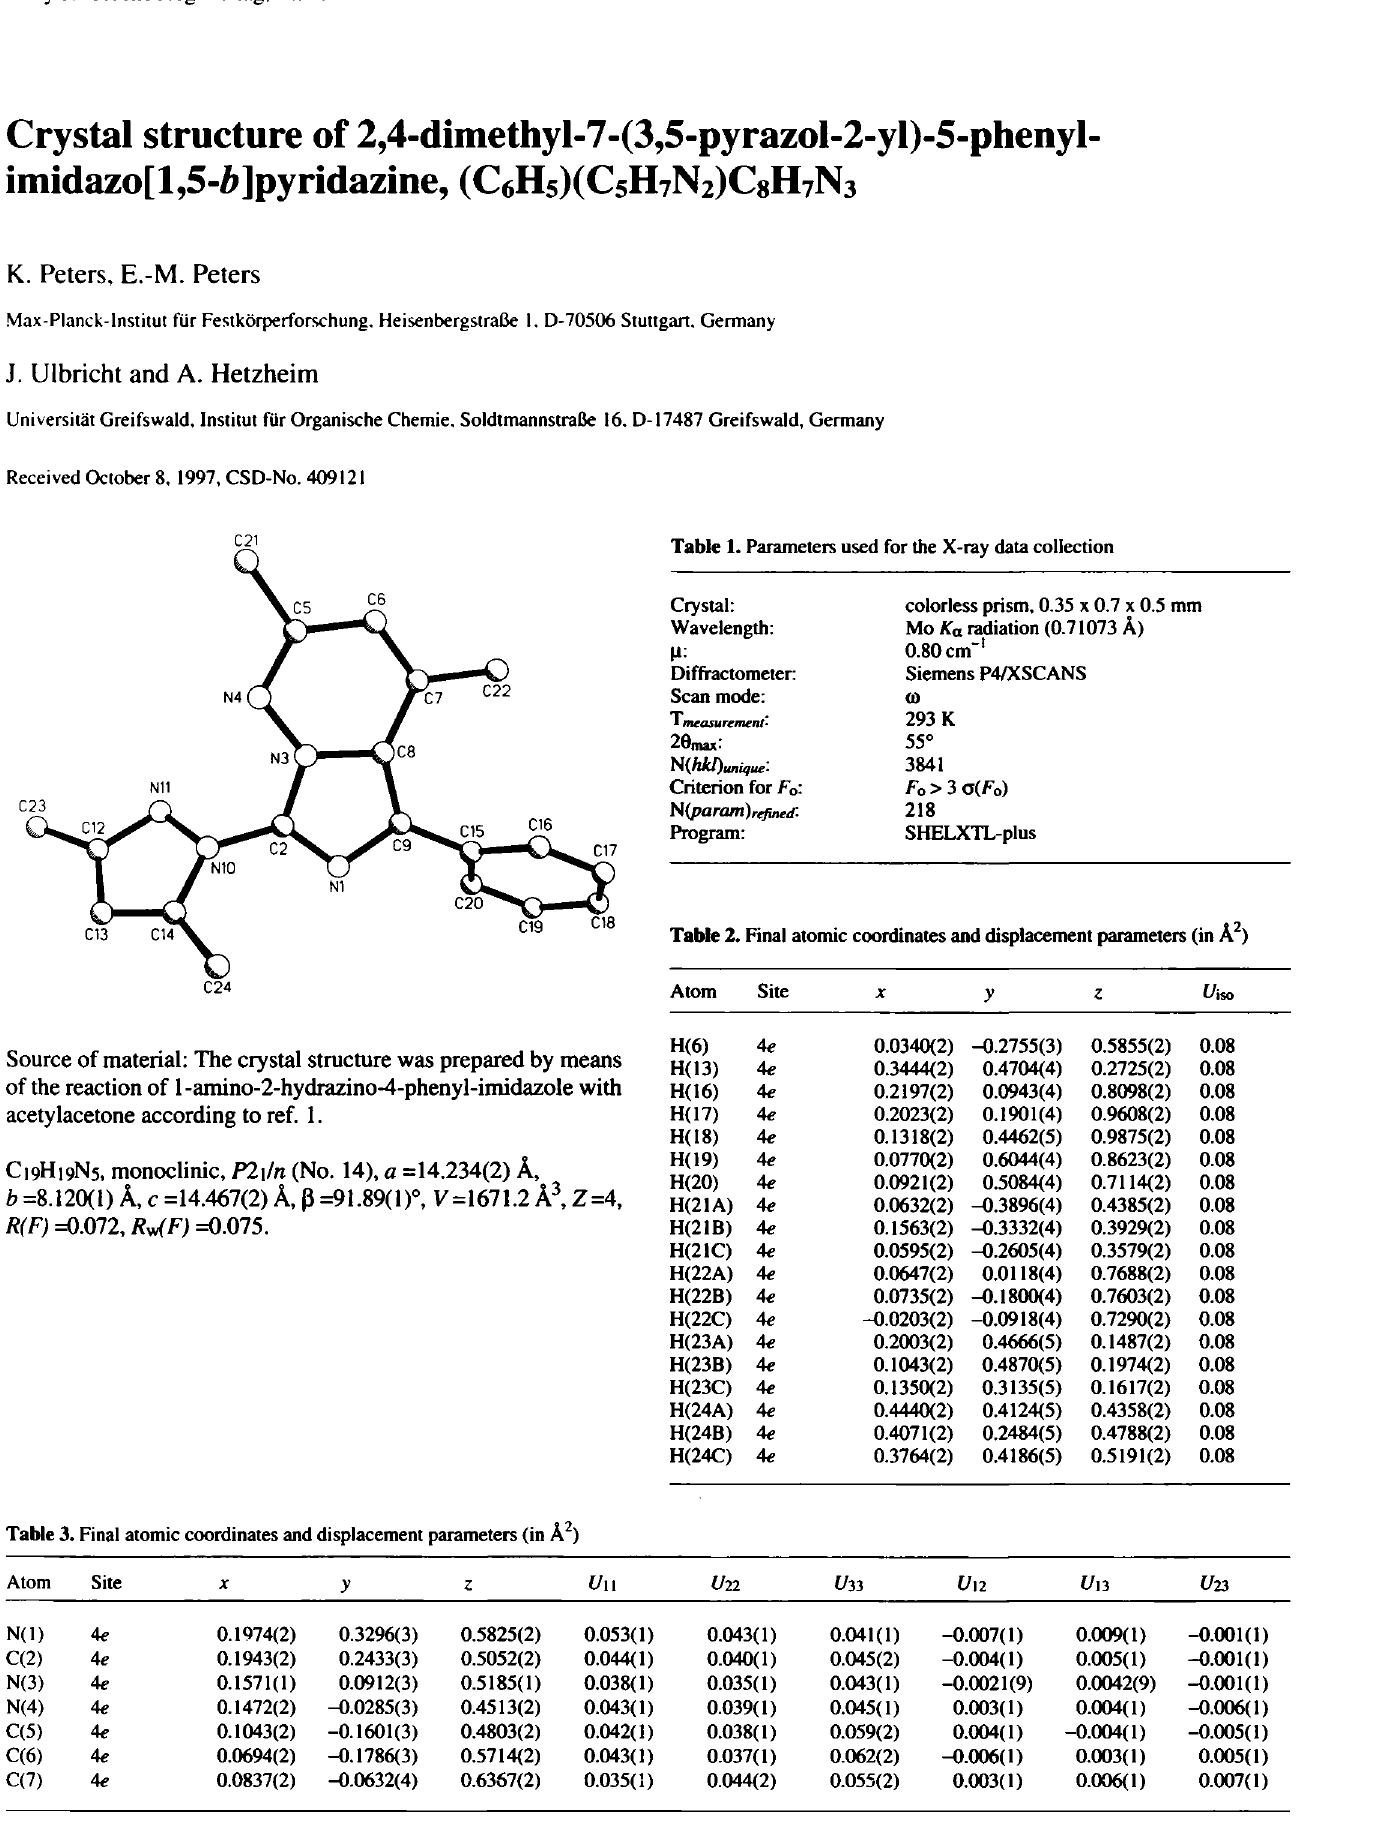
Table 3. Final atomic coordinates and displacement parameters (in Â^) Atom